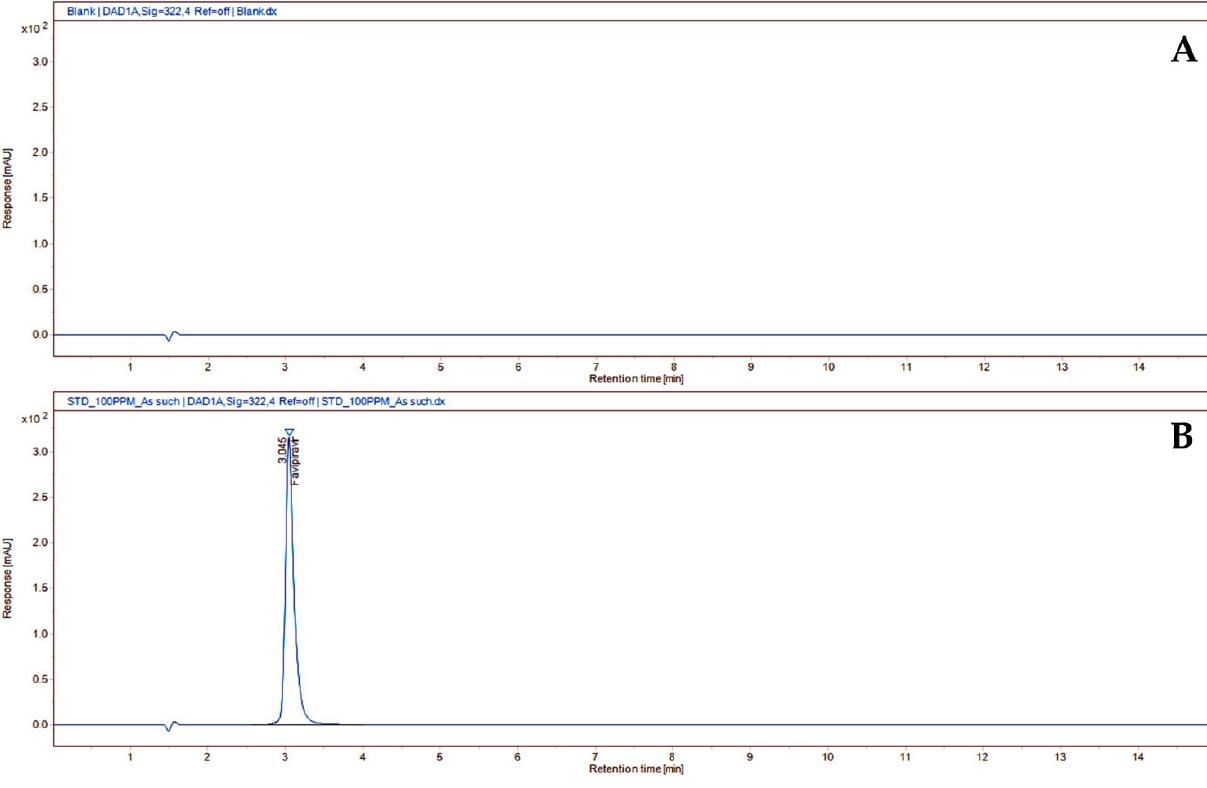
Figure 2. Typical HPLC chromatogram of the blank ( A ) and standard of favipiravir ( B